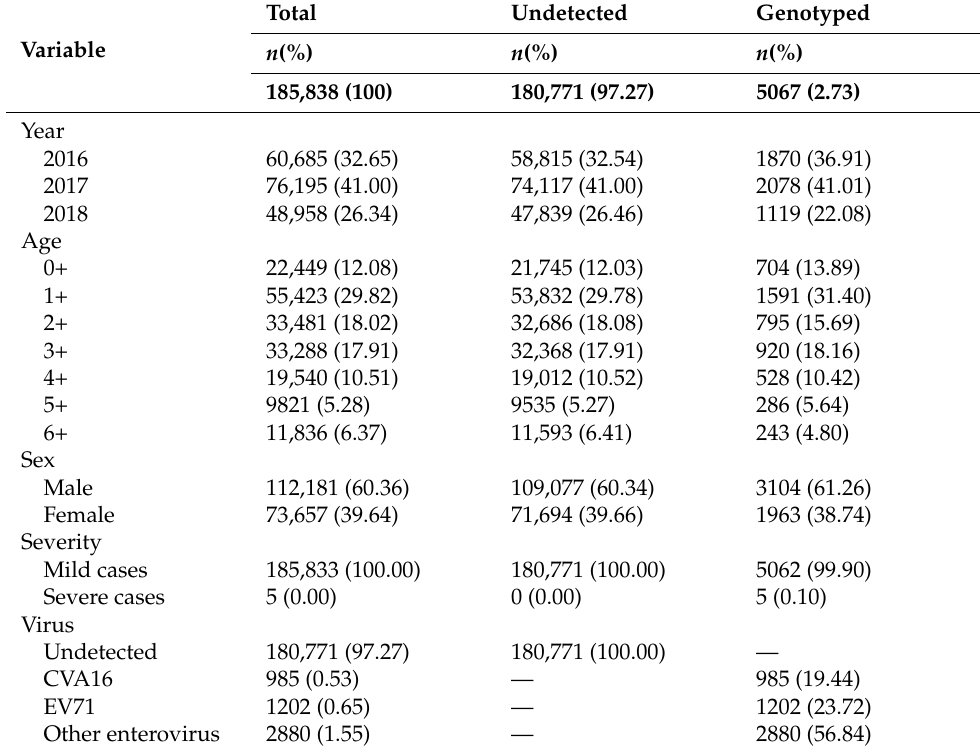
Table 1. Characteristics of HFMD (hand, foot, and mouth disease) cases by genotyped and unde-